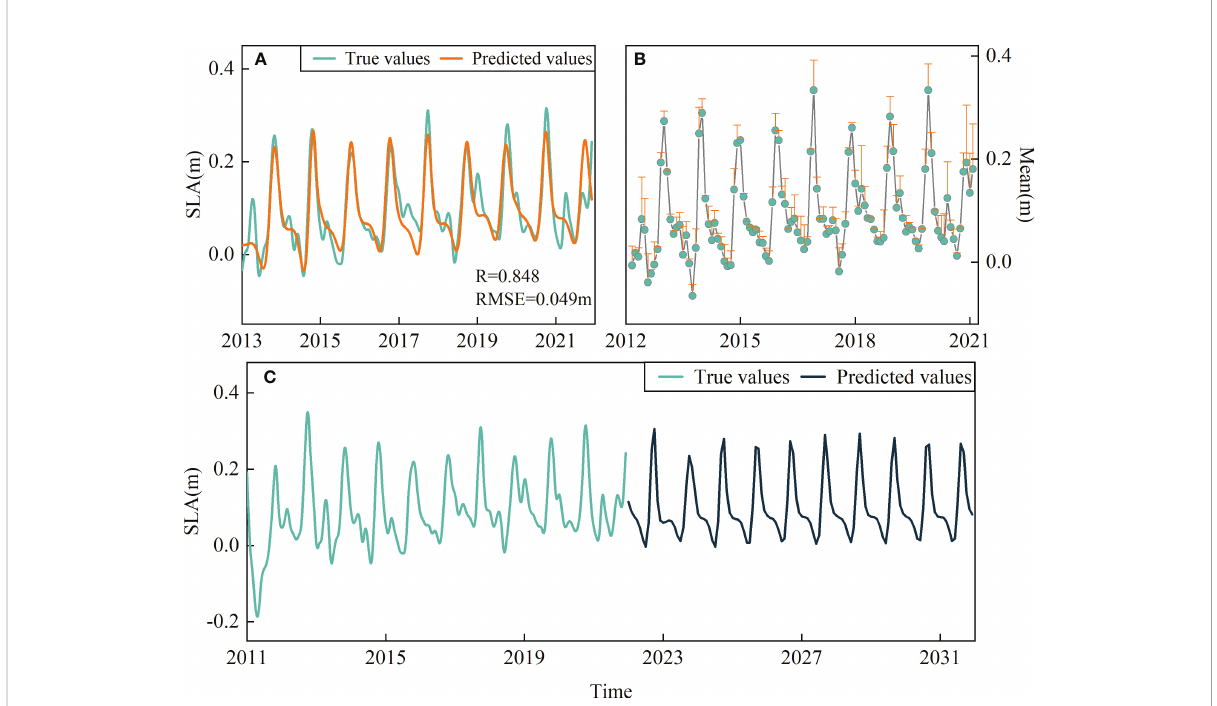
FIGURE 10 Predicted results of monthly average water level in the coastal zone of Beibu Gulf using the LSTM model. (A) true and predicted values for 2013-2021. (B) the error between predicted and true values for 2013-2021. (C) the future trend of monthly average water level from 2022-